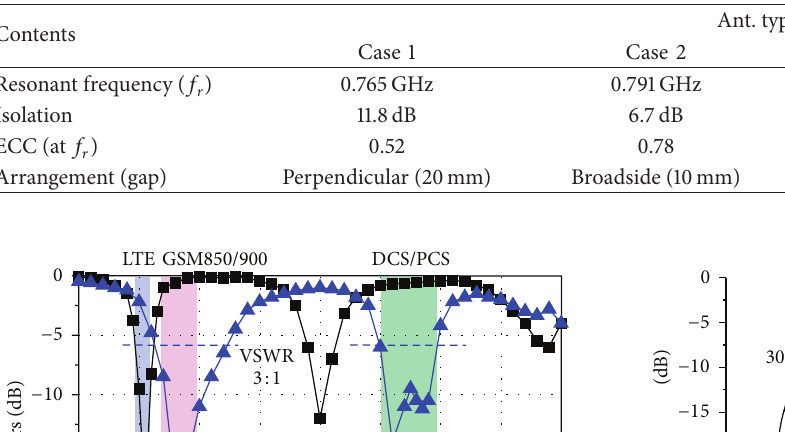
Table 1: Simulated results for each case.